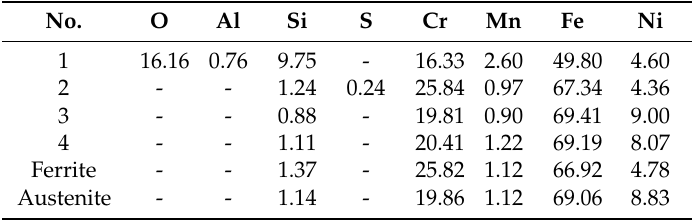
Figure 11. The SEI micrographs of the GTAW weld. Table 4. EDS compositional analysis (wt %) of the GTAW weld.